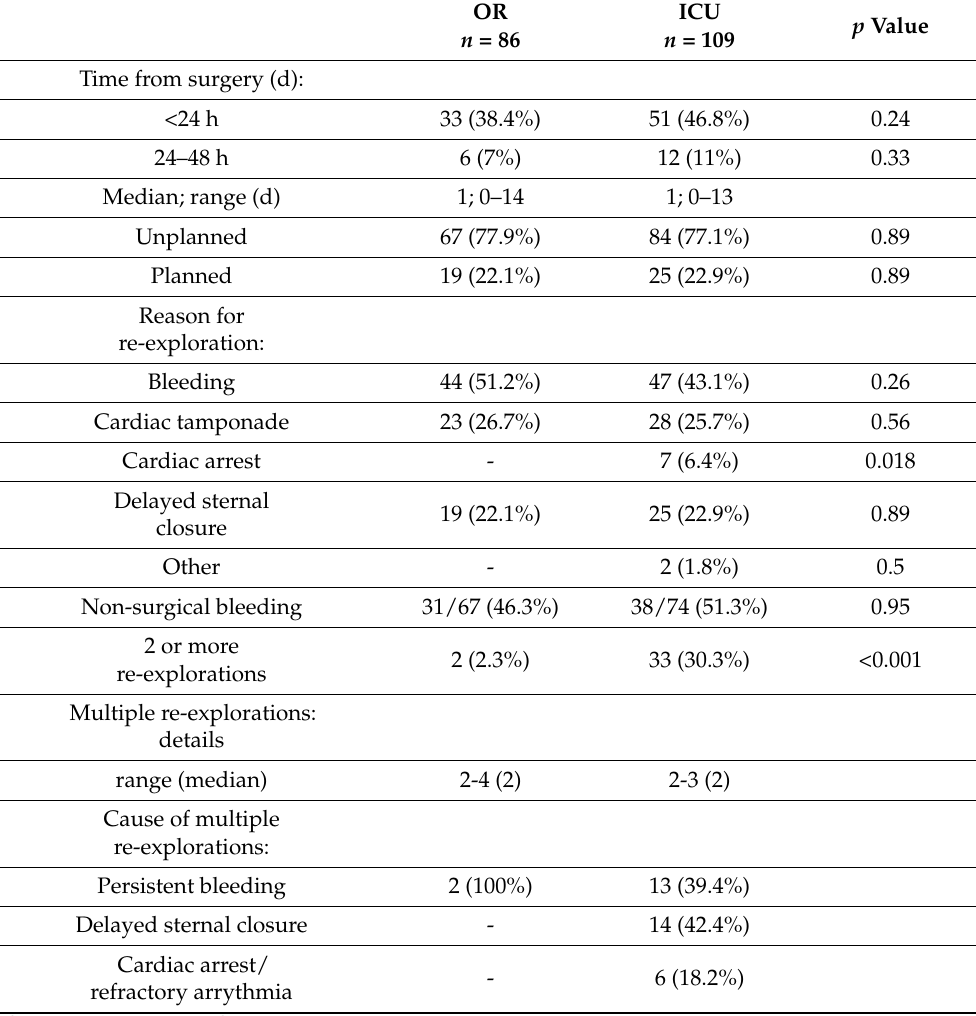
Table 3. Re-exploration(s)